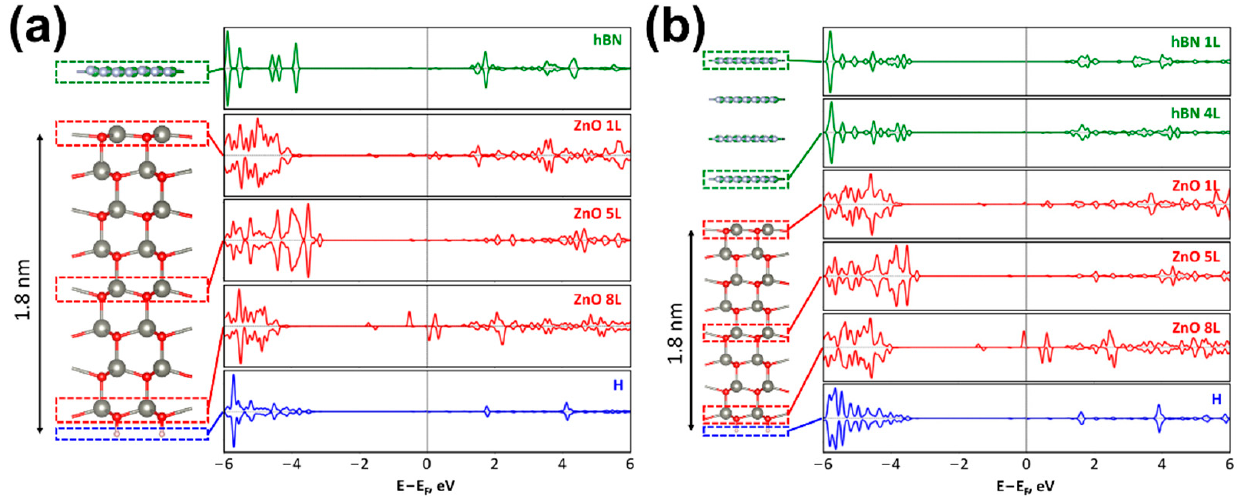
Figure 6. SEM images of h -BNnm ( a ), h -BNµm ( b ) and their Raman spectra ( c ).